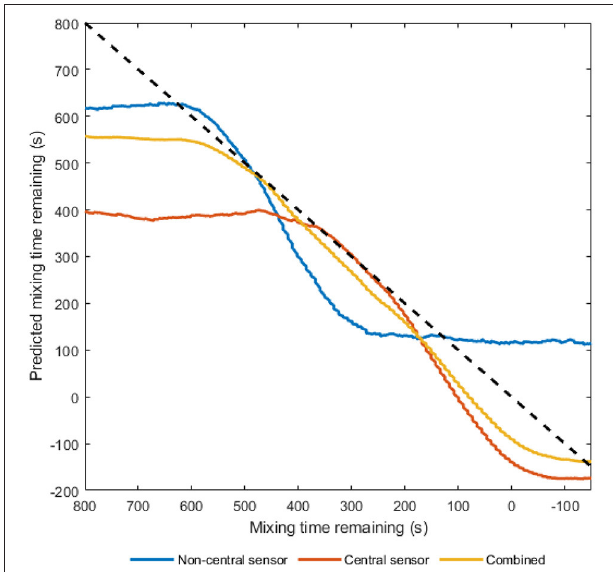
FIGURE 4 | A comparison between regression accuracies for predicting the time remaining until mixing completion for the honey-water batter mixing. The results displayed are from the non-central sensor, central sensor, and combining sensor outputs all using a time-domain input